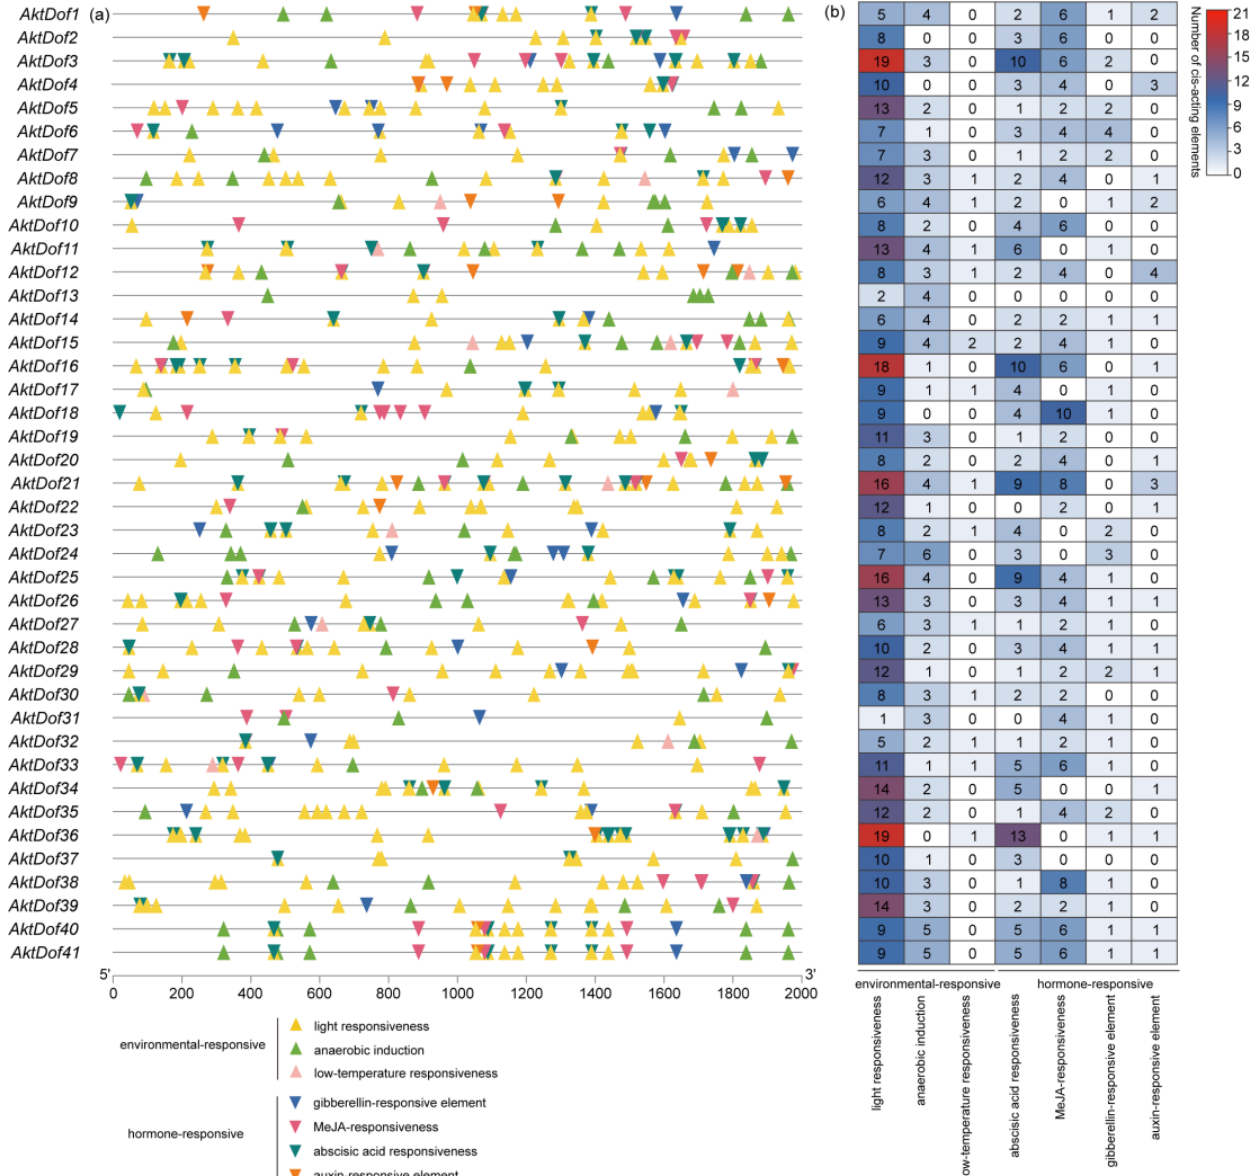
Figure 3. Visualization of transcription factor-binding sites (TFBSs) within the promoter region of AktDofs . ( a ) Two kilobase region upstream of the transcription start site of the AktDofs . ( b ) The num- ber of cis-acting elements of the two functional categories in the AktDofs is represented by different colors and numbers.